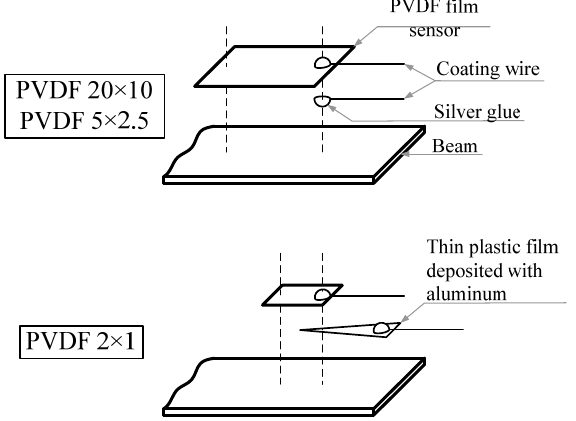
Figure 9. Illustration of bonding of the PVDF film